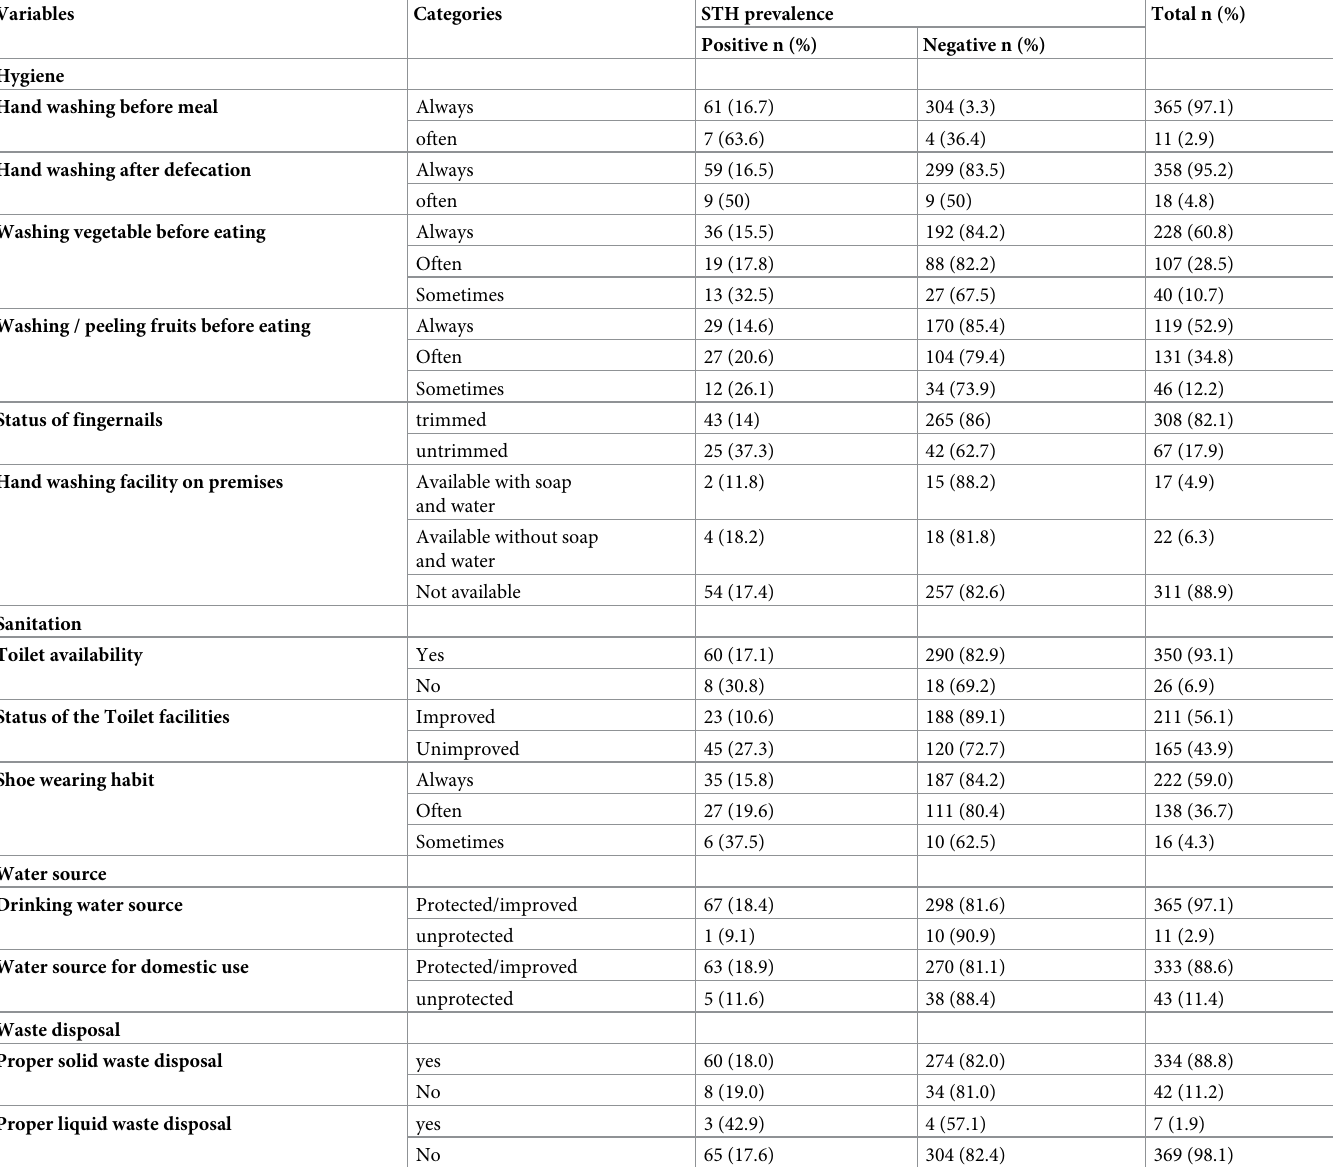
Table 3. Water supply, sanitation and hygiene conditions of the households and distribution of STH in the peri-urban area of Jimma town, Oromia, Ethiopia, May to July 2021 (n =